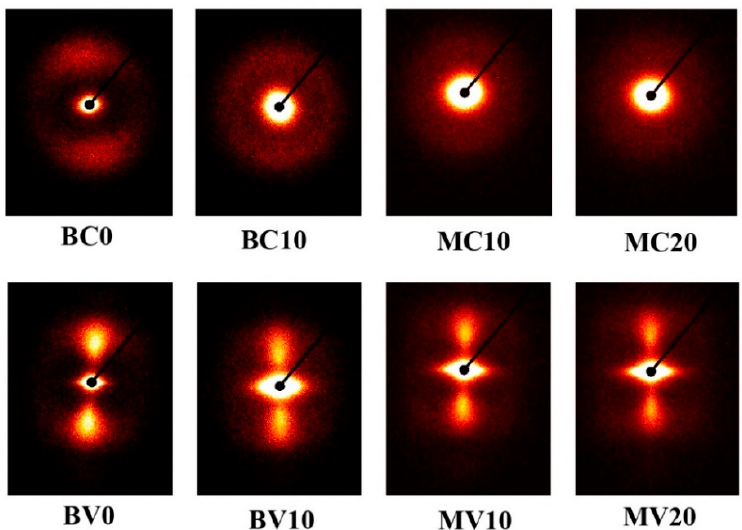
Figure 2. Two dimensional small angle X-ray scattering (2D-SAXS) patterns of some selected samples. The flow direction is